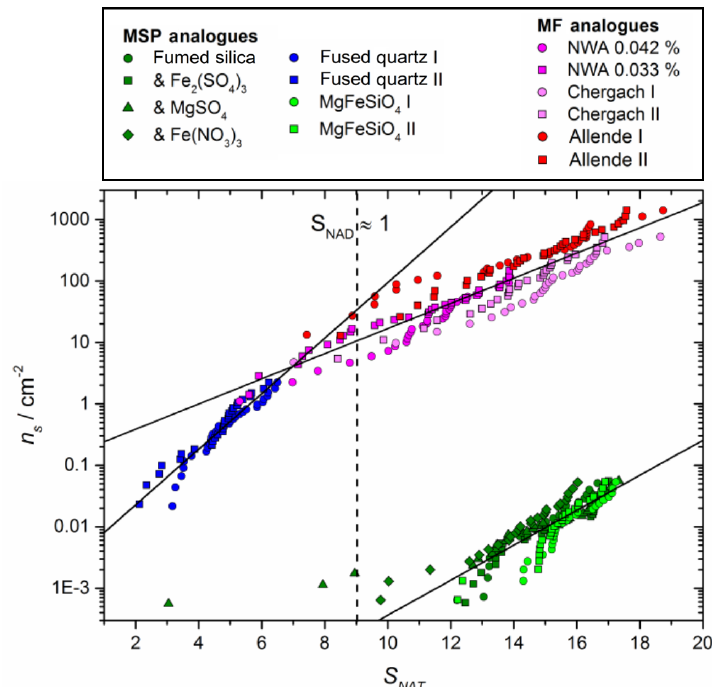
Figure 4. Nucleation activity of MSP and MF analogues investigated here expressed as active sites per unit surface area ( n s ) as a function of S NAT . The vertical dashed line shows the approximate S NAT at which NAD becomes stable. Samples were selected and their BET surface areas measured as analogues for both MSPs (Fused Quartz: 4.85 ± 0.06m 2 g − 1 , Fumed Silica: 195 ± 3m 2 g − 1 , MgFeSiO 4 : 208 ± 2m 2 g − 1 ) and MFs (NWA 2502 (CV3): 5.75 ± 0.05m 2 g − 1 , Chergach (H5): 0.44 ± 0.14m 2 g − 1 , Allende (CV3): 1.22 ± 0.15m 2 g − 1 ) . Log-linear fits have been added as a guide for the eye and to facilitate comparison with atmospheric